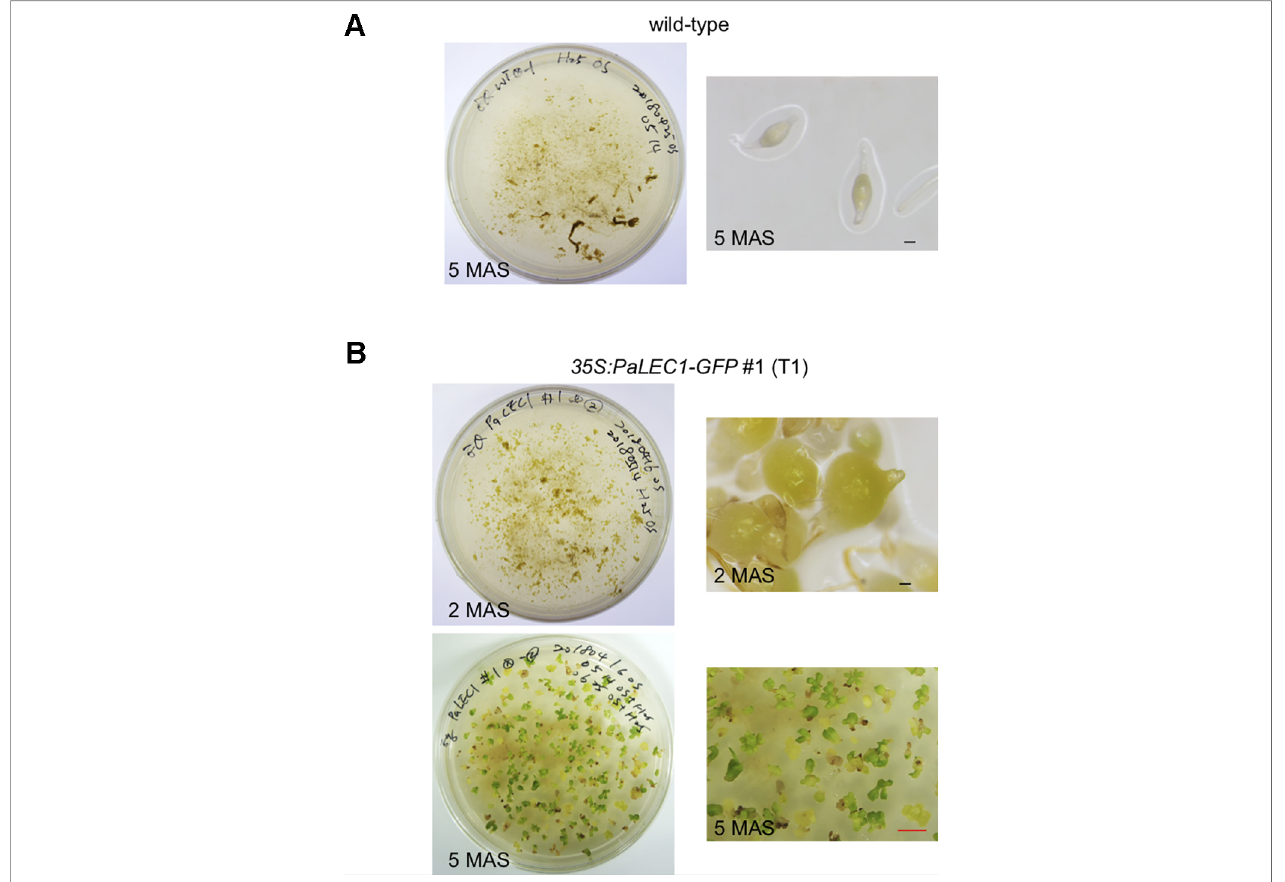
FIGURE 1 | Selection of T1 35:PaLEC1-GFP #1 transgenic plants on hygromycin plates. (A) Wild-type protocorms failed to develop on hygromycin-containing medium. (B) 35:PaLEC1-GFP #1 protocormscontinued to grow anddeveloped into seedlings 5 monthsafter sowing. MAS, month after sowing. Black scalebar = 100 m m. Red scalebar = 0.5